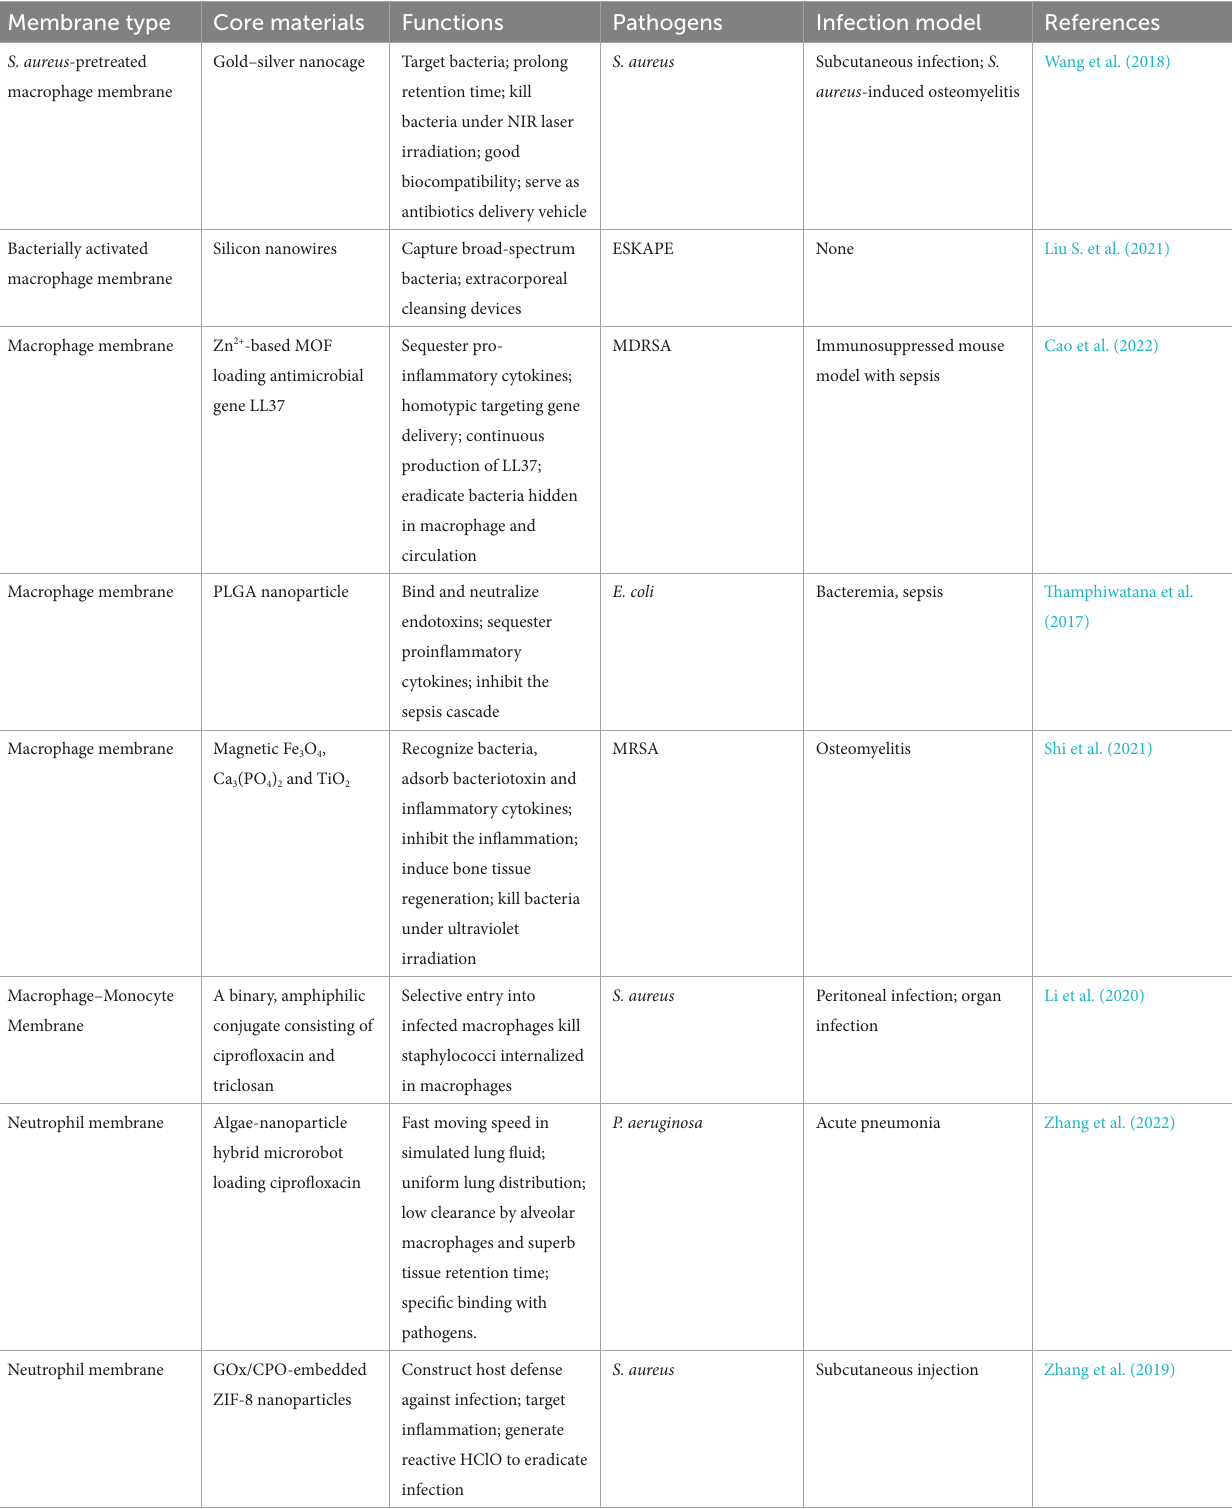
TABLE 2 Representative white blood cell (WBC) membrane coated nanoparticles for therapy of bacterial